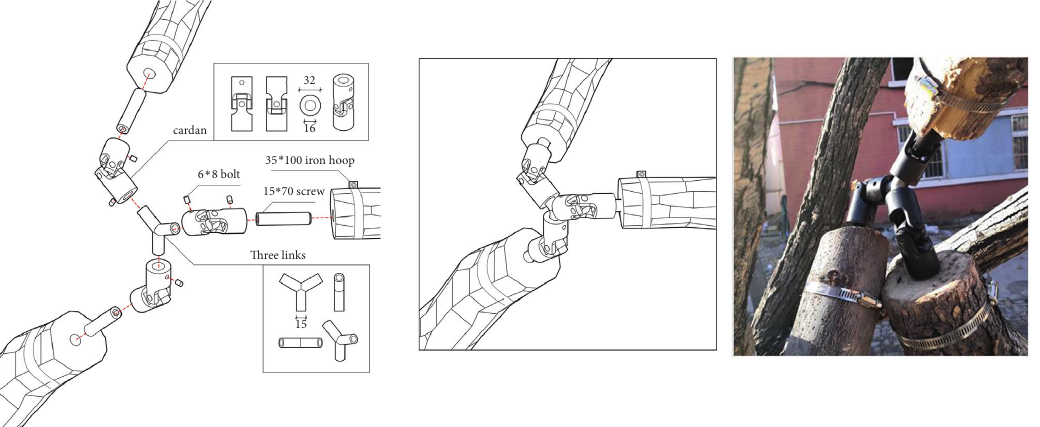
Figure 12: Joints.